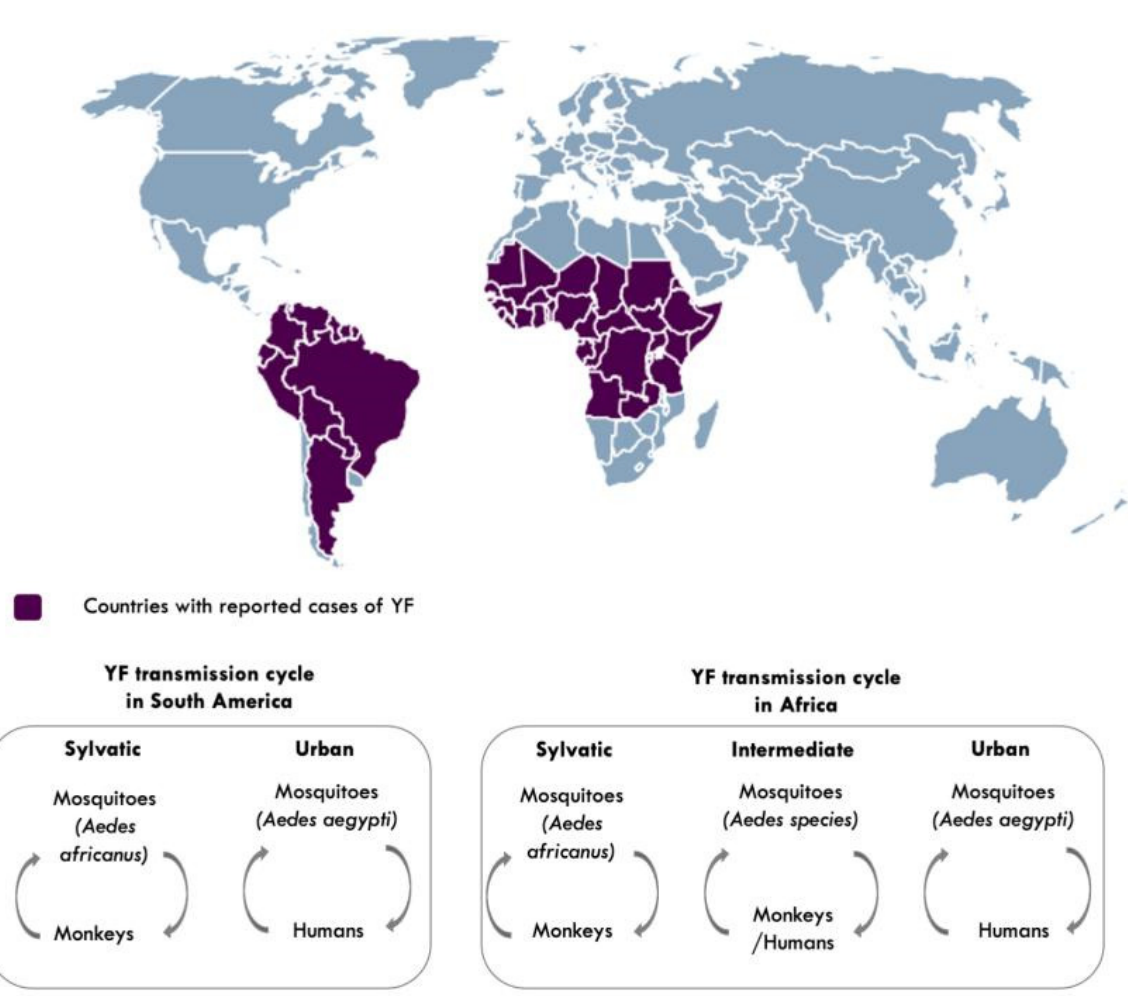
Figure 3. Countries with reported cases of yellow fever and YF transmission cycles [2,21]. Aedes species responsible for intermediate transmission include: Aedes furcifer, Aedes luteocephalus, Aedes taylori, Aedes metallicus, Aedes vittatus, Aedes simpsoni complex. Map made using (https://simplemaps.com accessed on 25 March 2021).